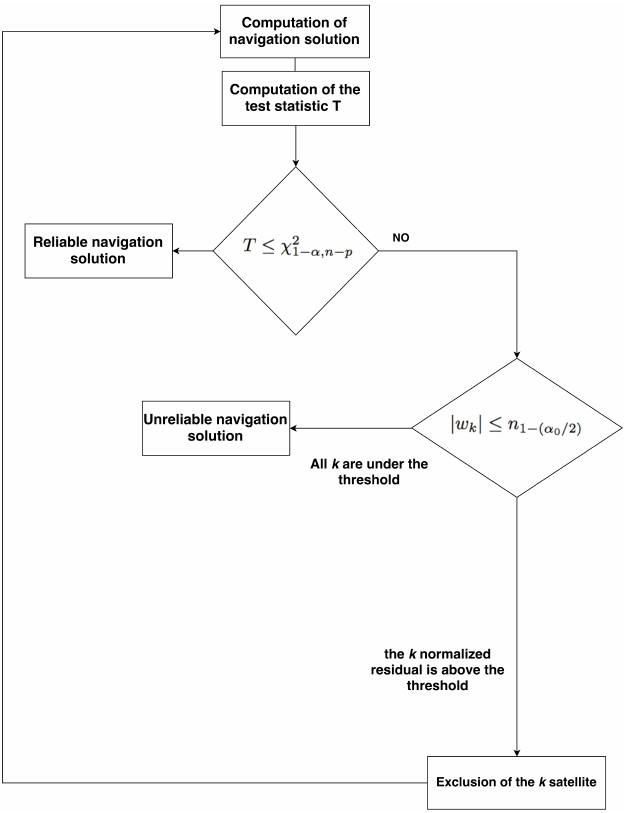
Figure 10. Block diagram of the FDE